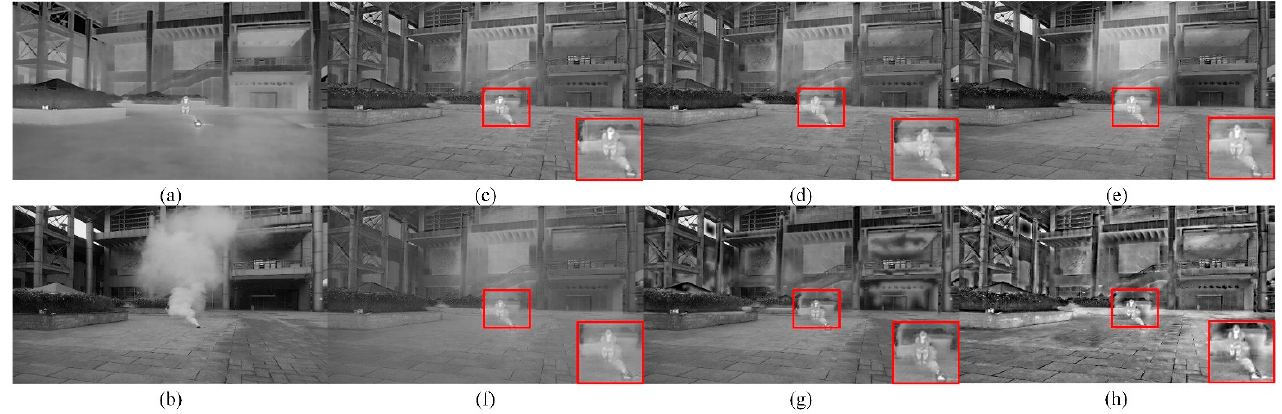
Figure 2. Fused images in the smoke scene using six different methods. ( a ) Infrared image; ( b ) Visible image; ( c ) MDLatLRR; ( d ) MGFF; ( e ) MSID; ( f ) ResNet; ( g ) RGFF; ( h ) Proposed.